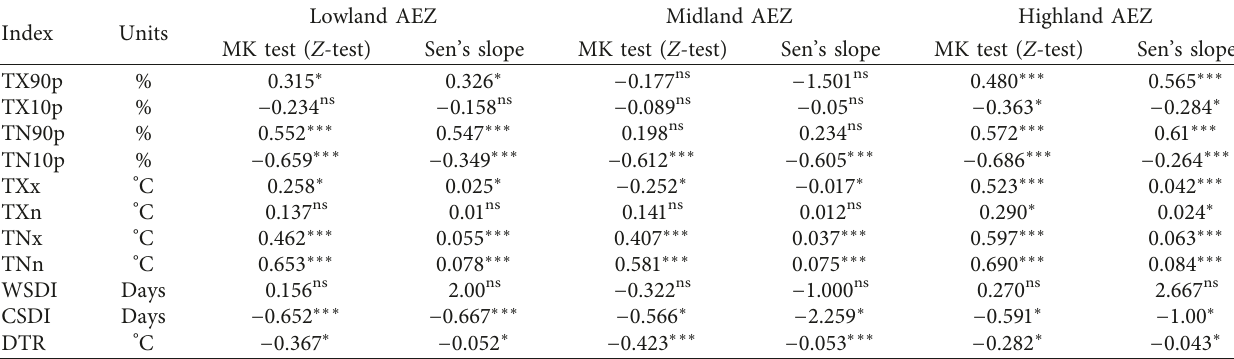
Table 3: Trends in temperature extreme indices per year by